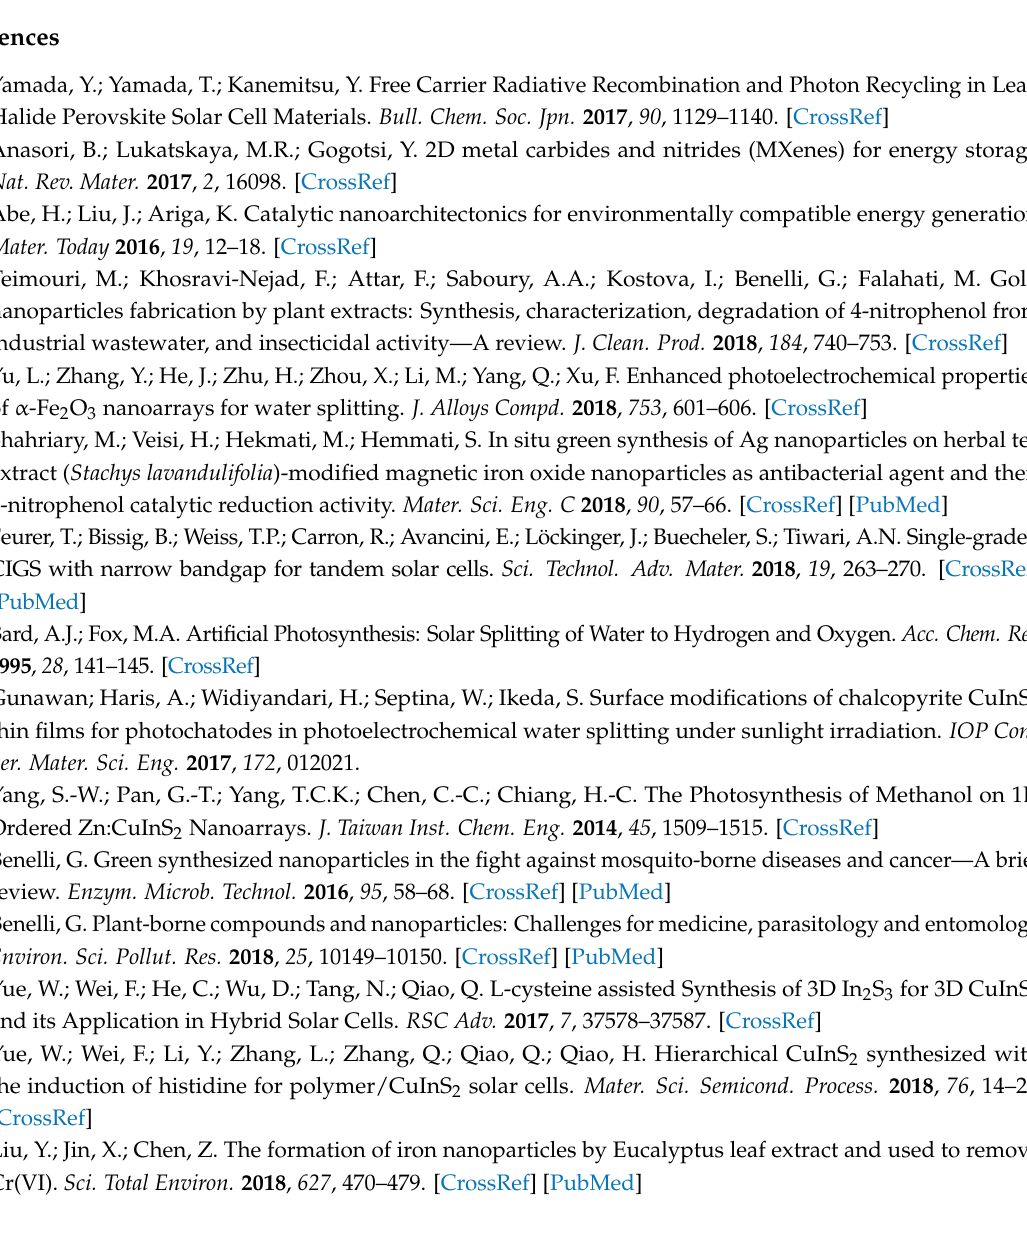
agglomerates. Figure S3, XRD pattern of CuInS 2 films synthesized with L -cysteine for different reaction times, 6, 9, 15, 18, 21 and 48 h, at 150 ◦ C. Signals stemming from FTO are marked with *, the ones originating from CuInS 2 with #. Figure S4, UV-vis spectra of CuInS 2 thin films on FTO substrate, synthesized solvothermally with L -cysteine grown for different reaction times at 150 ◦ C. Figure S5, (a) HR TEM image and (b) electron diffraction pattern of a CuInS 2 film synthesized with L -cysteine for 3 h at 150 ◦ C (film_3 h). Figure S6, (a) SEM image and (b) XRD pattern of film_100 ◦ C. Only pure FTO can be observed in SEM and XRD. Figure S7, XRD pattern of CuInS 2 films synthesized with L -cysteine at different reaction temperatures, 100, 140, 150, and 180 ◦ C, for 18 h. Signals stemming from FTO are marked with *, the ones originating from CuInS 2 with #. Figure S8, UV-vis